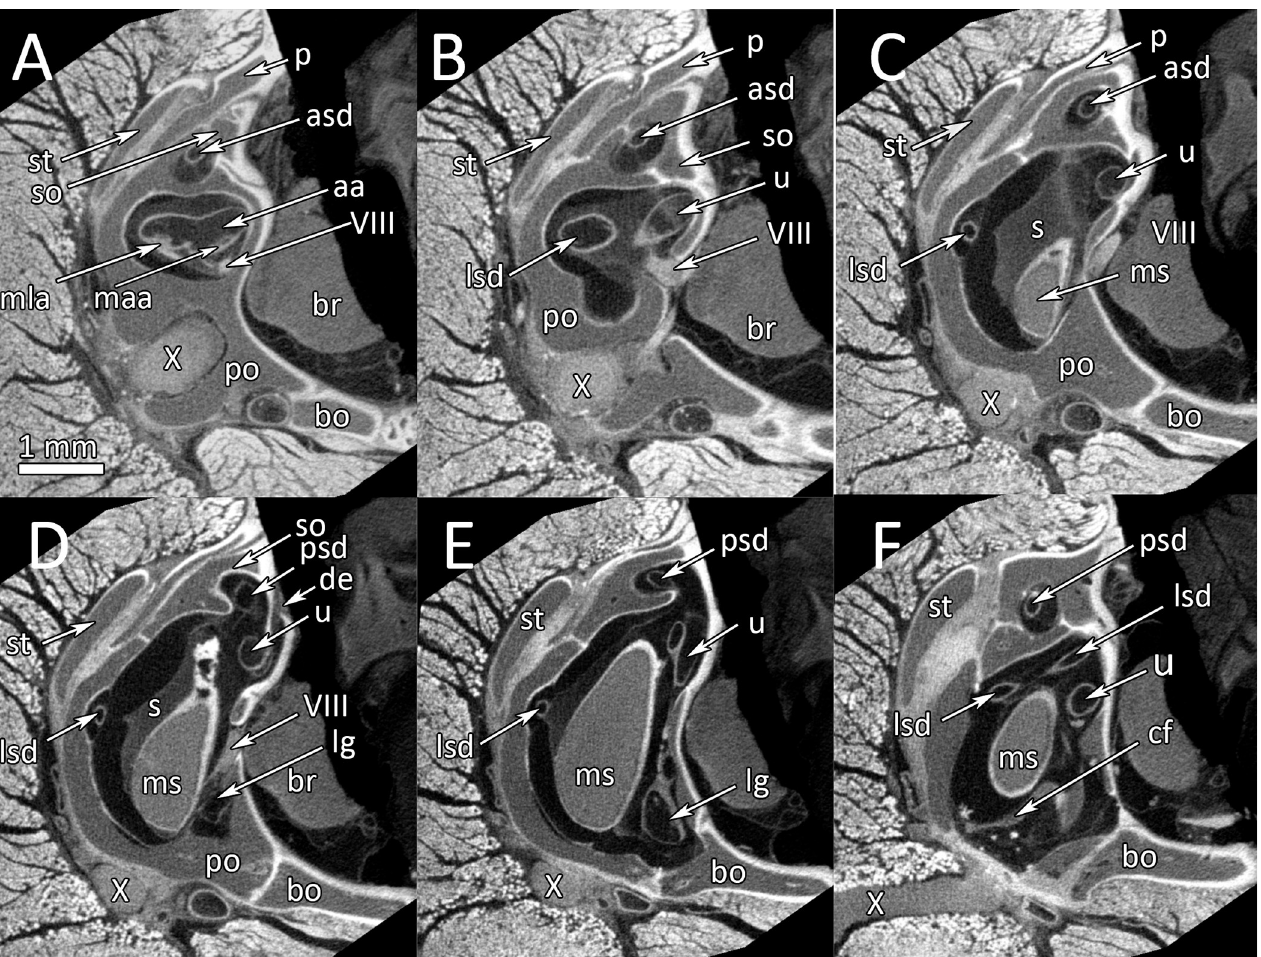
Fig 3. Python regius , serial μ CT images from rostral to occipital through the inner ear in a wildtype ball python (control animal #1). (A) Image #199. (B) Image #225. (C) Image #283. (D) Image #315. (E) Image #374. (F) Image #461. Scale bar in (A) applies to all images. Abbreviations: aa, anterior ampulla; asd, anterior semicircular duct; bo, basioccipital; br, brain; cf, columella foodplate; de, ductus endolymphaticus; lg, lagena; lsd, lateral semicircular duct; maa, macula anterior ampulla; mla, macula lateral ampulla; ms, macula sacculi; p, parietal; po, prootic; psd, posterior semicircular duct; s, sacculus; so, supraoccipital; st, supratemporal; u, utriculus; VIII, nervus stato-acusticus; X, nervus